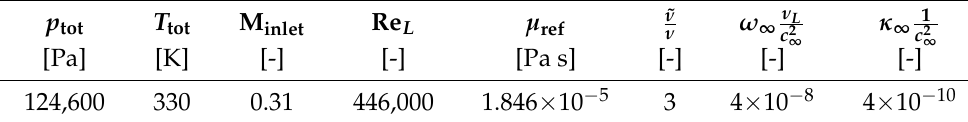
Table 6. Input parameters for eleventh standard configuration, case